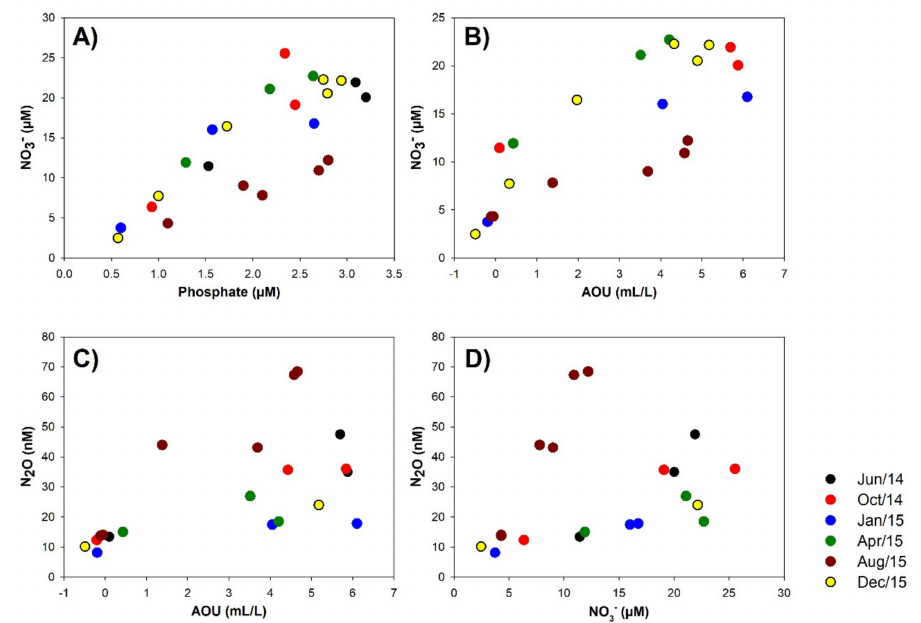
Figure 4. Relationships between: ( A ) nitrate and phosphate; ( B ) nitrate and Apparent Oxygen Utilization (AOU); ( C ) nitrous oxide and AOU; and ( D ) nitrous oxide and nitrate during the different sampling